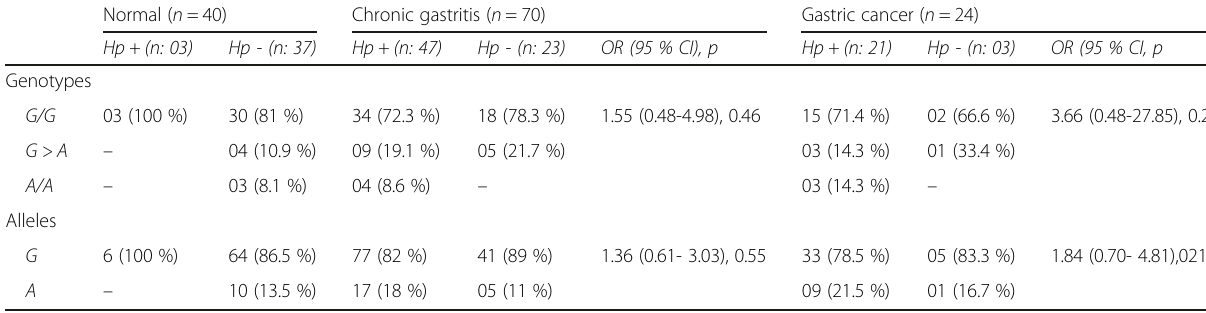
Table 2 Genotype and allele frequencies of − 308 G > A polymorphism of the TNF- α gene, adjusted for the presence of. H pylori in patients with normal gastric mucosa, gastritis and gastric cancer Normal ( n = 40) Chronic gastritis ( n = 70)